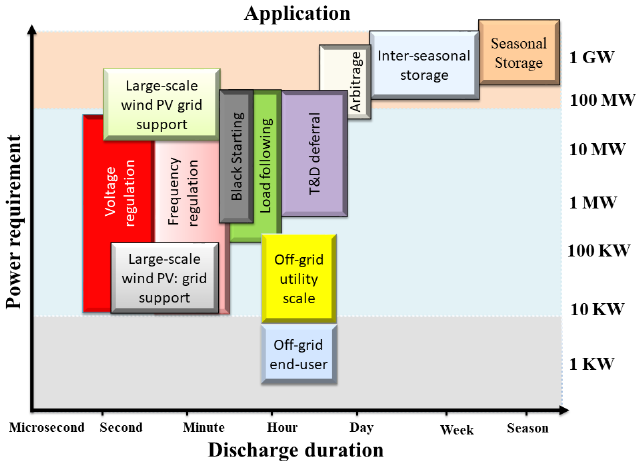
Figure 5. The categorization of ESS applications is based on the power capacity of input and output and their discharge duration time.